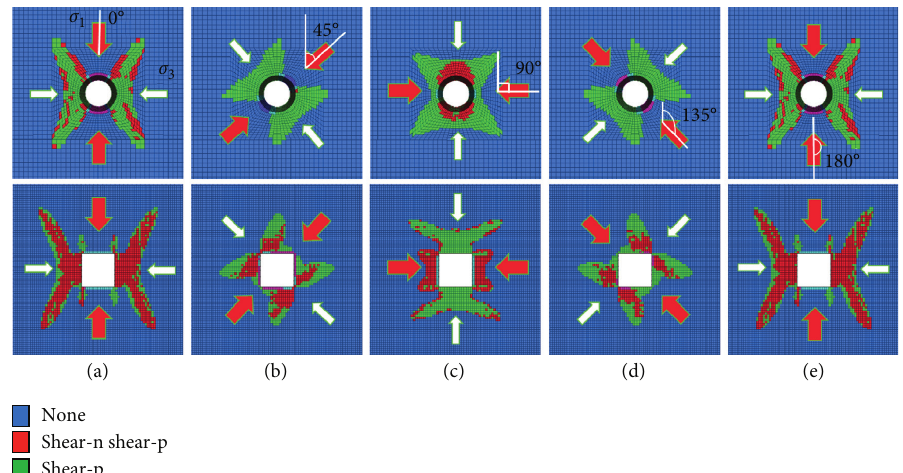
Figure 13: The shape of plastic zone under the change of principal stress deflection angle of surrounding rock of circular and rectangular tunnels under numerical simulation. (a) α � 0 ° . (b) α � 45 ° . (c) α � 90 ° . α � 135 ° . (d) α � 180 °